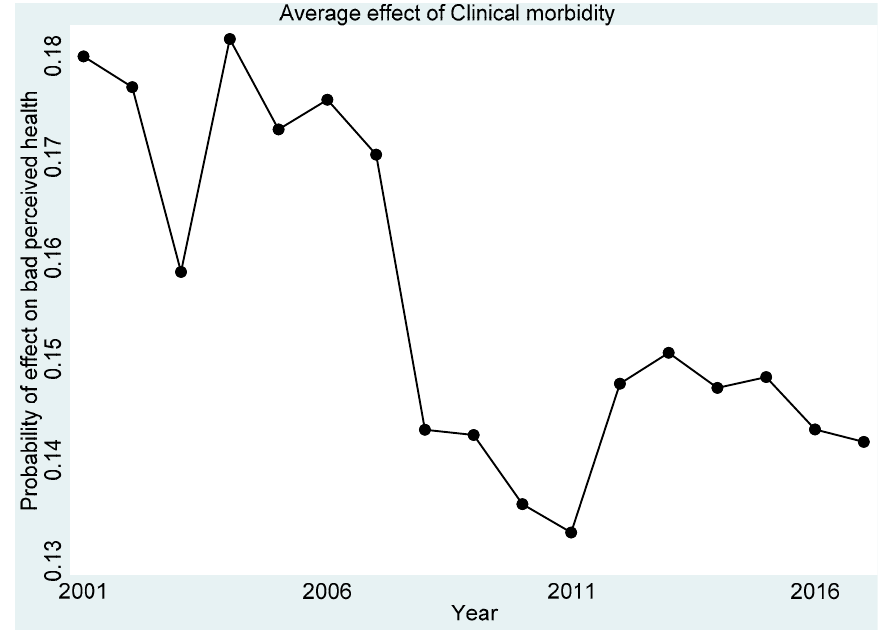
Figure 1. Probability of effects on “very bad” perceived health from the average effect of clinical morbidity.